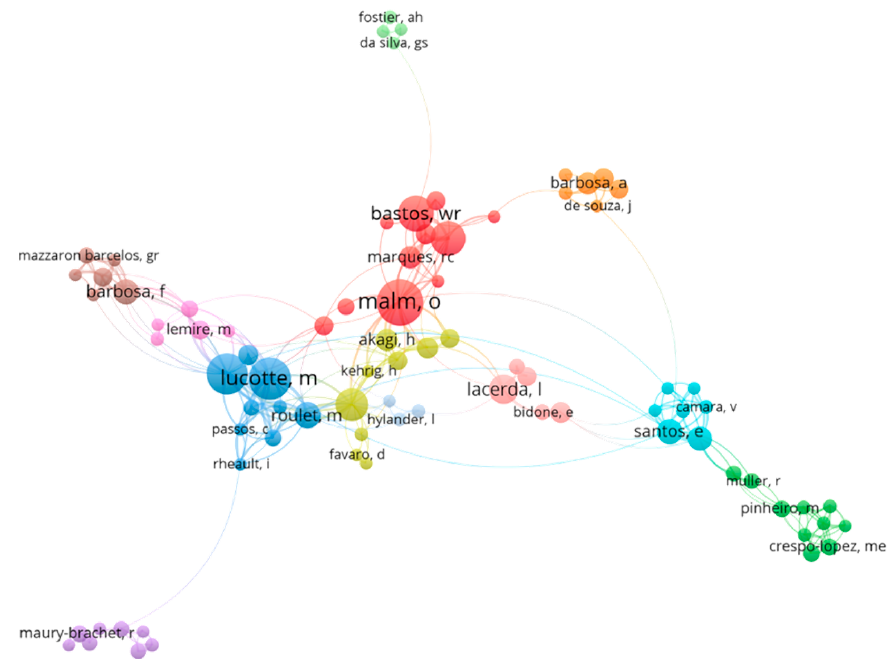
Figure 3. Co-authorship network regarding Hg research in the Amazon between 1991 and 2017.